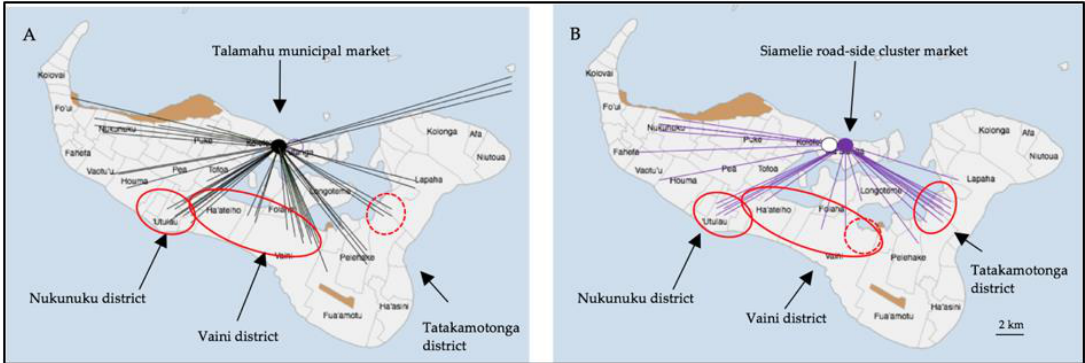
Figure 4. The location of farms supplying the main fruit and vegetable markets on Tongatapu Island. ( A ) Talamahu municipal market in central Nuku’alofa, Tongatapu Island. ( B ) Siamelie road-side cluster market Ma’ufanga, Tongatapu Island. Map source: Open street map 2019 and KoBoToolBox™ with survey overlays.